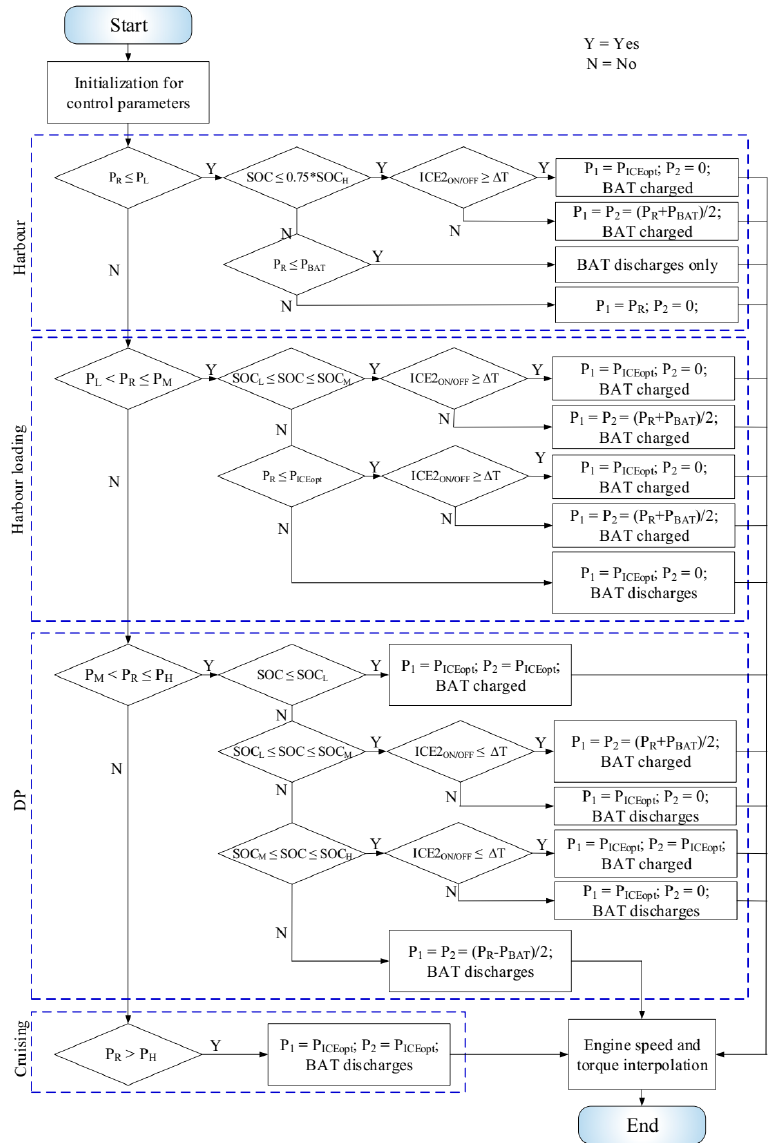
Figure 9. ERBC control block